Question: What visual encoding does this figure use to show its data?
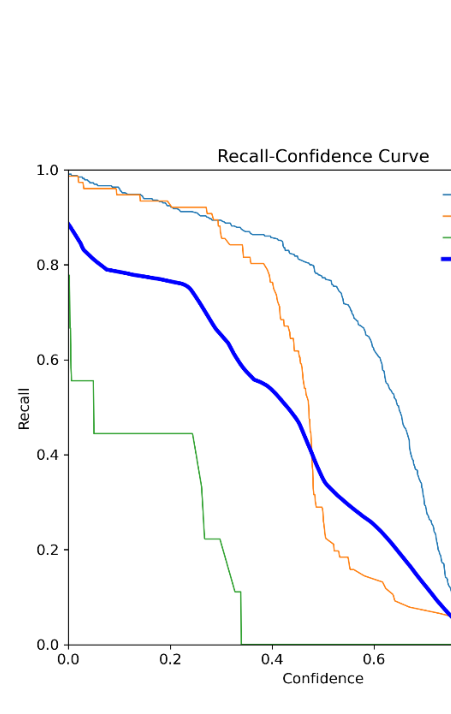
Answer: line